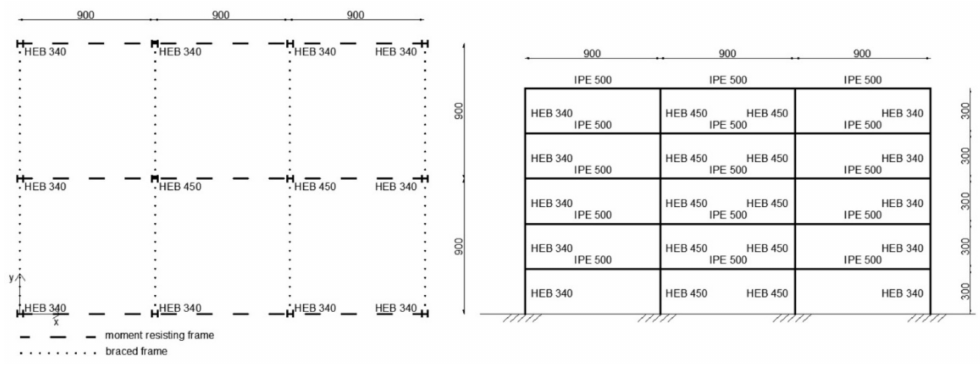
Figure 7. Case study building geometry